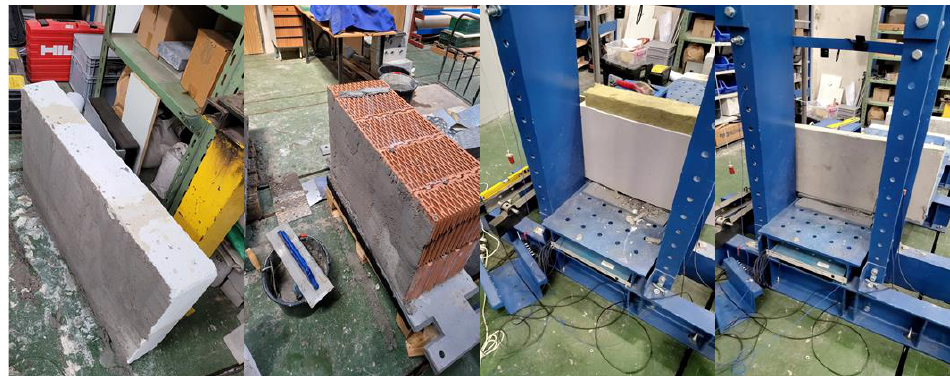
Figure 3. Testing samples, from the left — aerated concrete, ceramic brick, plasterboard, reinforced concrete .